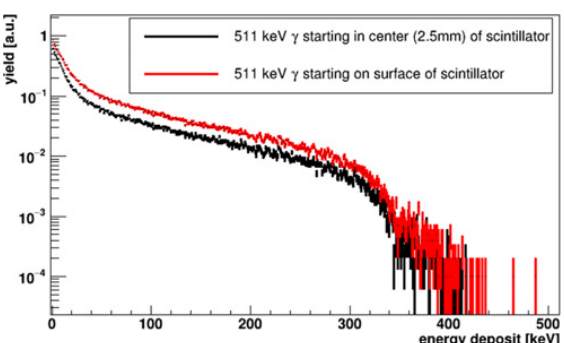
Figure 3. Simulation of the energy deposition of a single 511keV gamma in a plastic scintillator for a gamma starting in 2.5 mm depth and on the surface of the scintillator. The scintillator is 5 mm thick and its size is 160 × 440 mm 2 . The starting directions of the gammas are evenly distributed. 80% to 90% of the gammas (depending on the starting position) will not interact with the scintillator material.